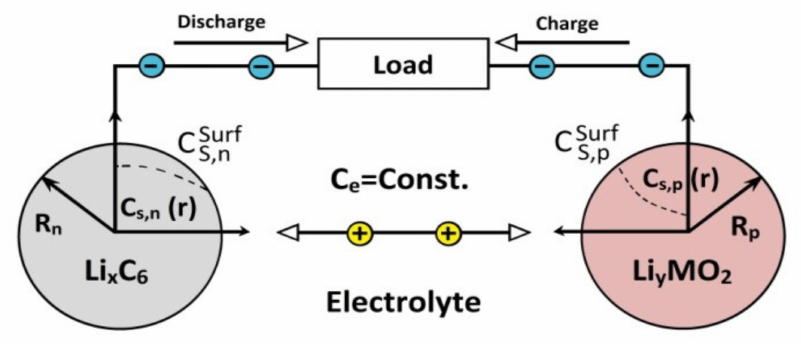
Figure 4. Schematic of the single-particle model (SPM) of an Li-ion